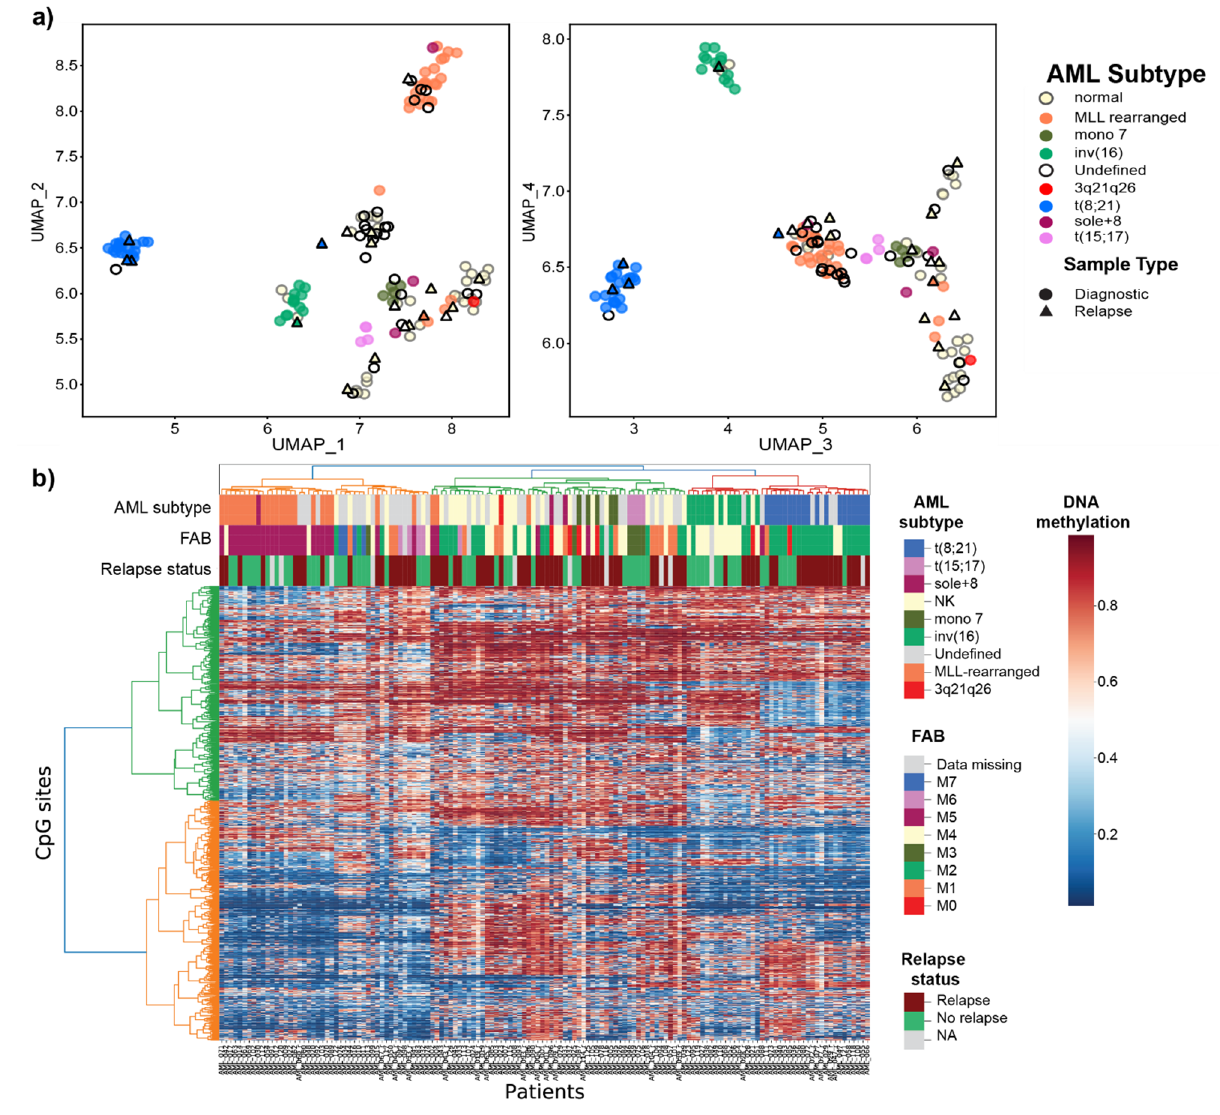
Figure 1. Data representation in space for the 142 pediatric AML patient samples for the selected 1300 CpG sites. ( a ) DNA methylation data projection in 2D space in a UMAP plot for UMAPs 1–2 (left) and 3–4 (right). Each point represents a patient sample. All samples are labeled by cytogenetic subtype, samples with unknown subtype (undefined) are shown as black circles with no fill (N = 24, diagnostic samples), and samples taken at relapse are shown by filled triangles colored by cytogenetic subtype (N = 19, relapse samples). ( b ) DNA methylation heatmap ordered by hierarchical clustering. Each row in the heatmap denotes a CpG site and each column is a patient. Cytogenetic subtype, FAB classification, and relapse status are shown as annotated bars over the plot.